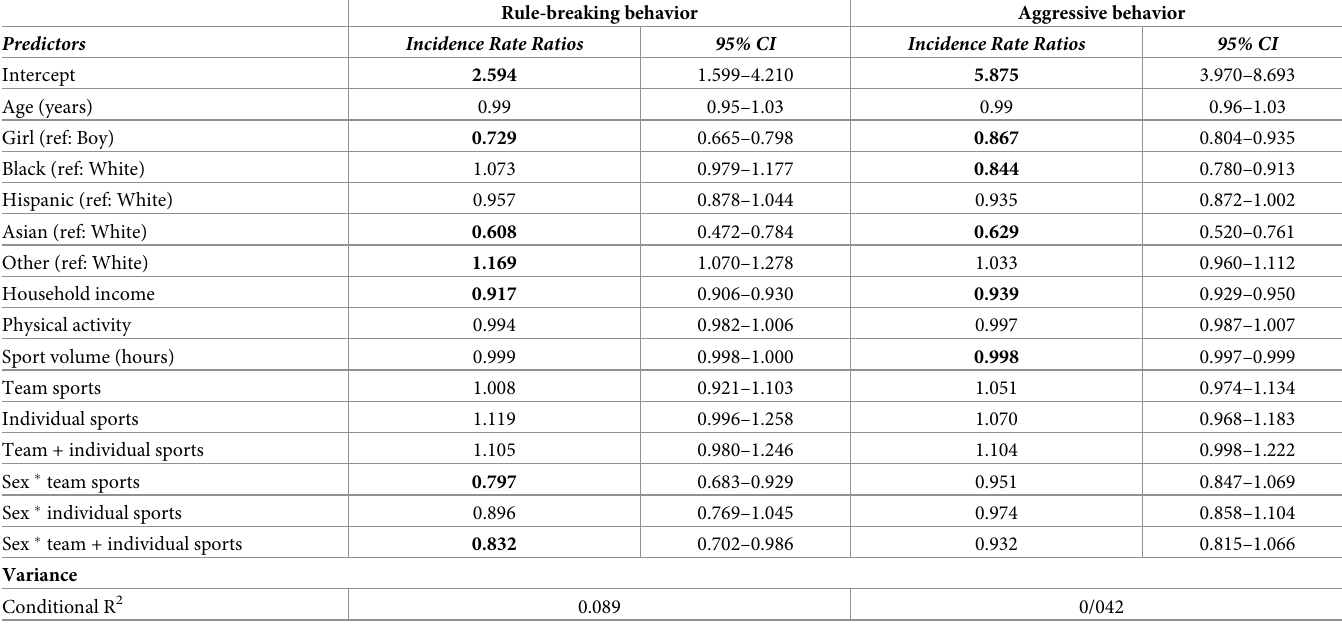
Table 5. Associations between types of sport participation and mental health